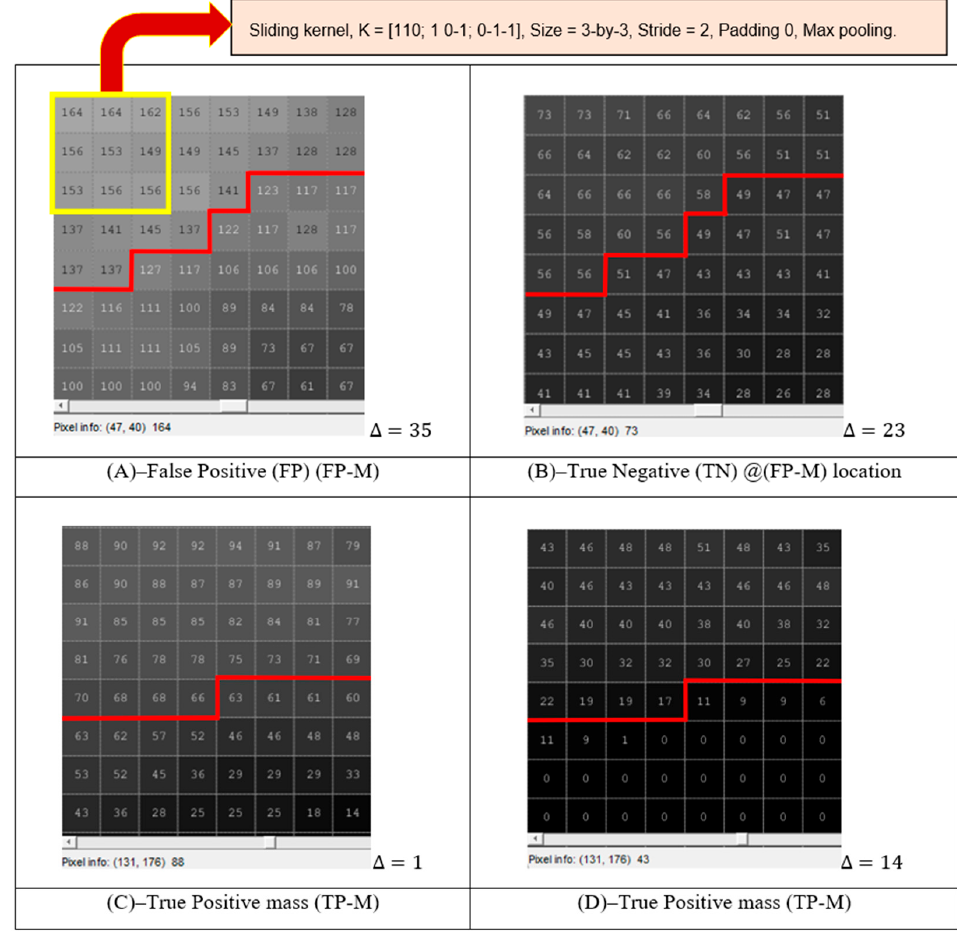
Figure 7. ( A ) FP detected mass edge on CLAHE image. ( B ) Corresponding location of TN mass location based on ( A ) on the proposed SbBDEM image result. ( C ) TP detected mass edge on the CLAHE image. ( D ) Corresponding TP location of detected mass location based on ( C ) on the proposed SbBDEM image result. The analysis is made from Figure 6E,J,O, where ∆ is the pixel edge difference. The lighter region above the red lines indicates the mass region.